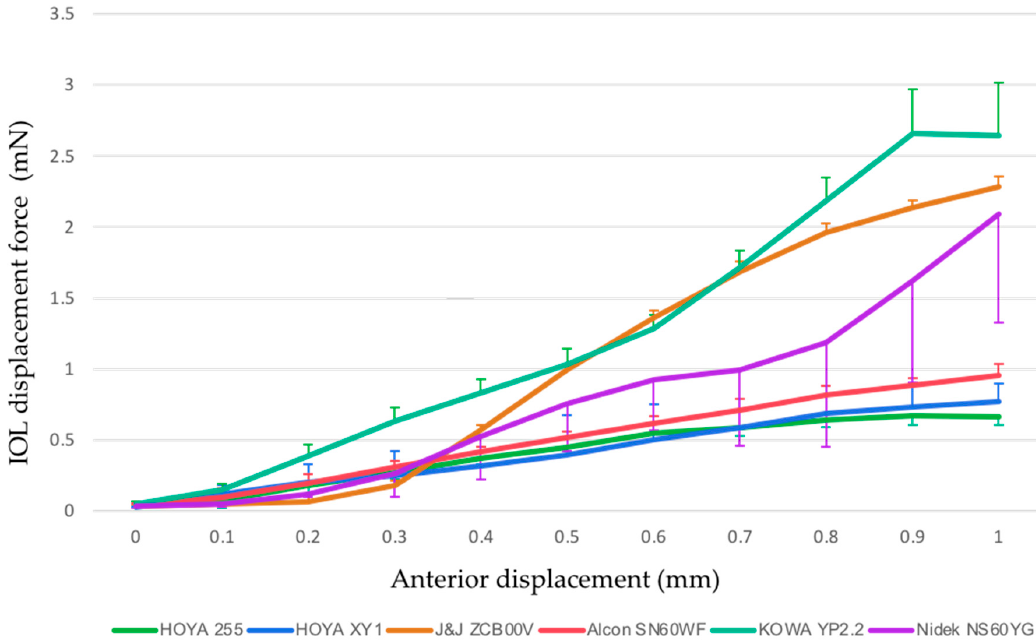
Figure 3. Changes in the IOL displacement force from the 0 and 1 mm points in each IOL model. Error bar, standard deviation. Table 2. Forces required for anterior displacement of each IOL model (mN).